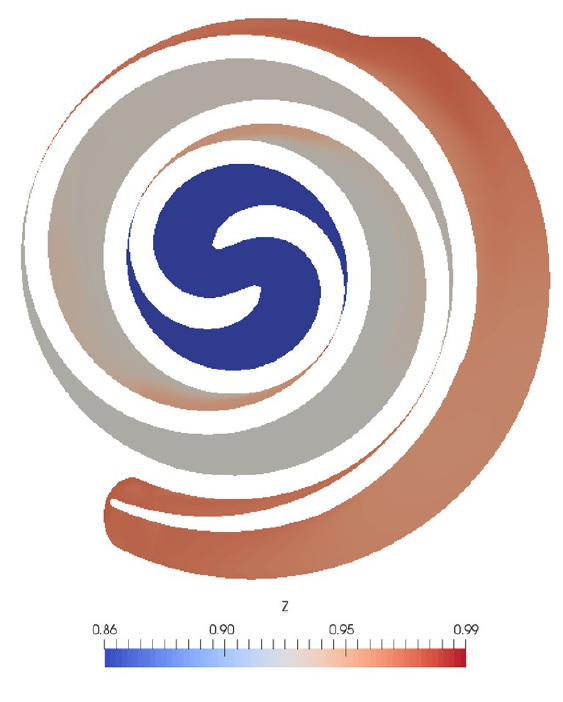
Figure 6. Compressibility factor for R134a during the operation of the